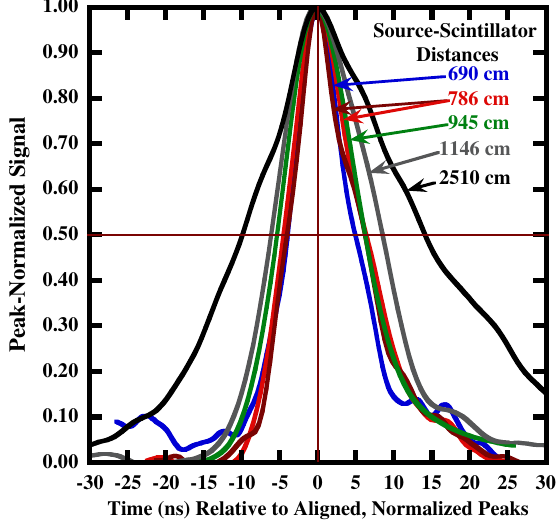
FIG. 6. Comparison of all six usable nTOF channels in shot 2584, smoothed, normalized, and aligned at the peak ( t FWHM is depicted. Signals above the FWHM are roughly symmetric, with the exception of signal 5A1 at 2510 cm from the source.